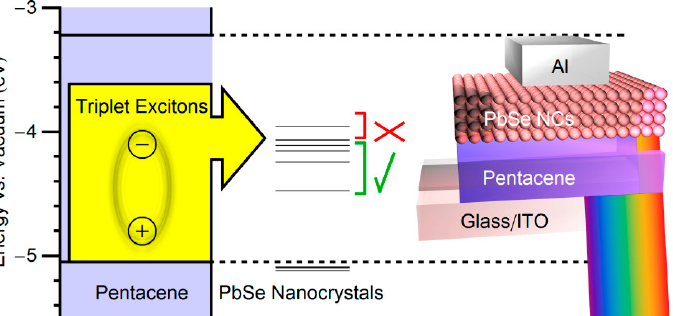
Figure 12. Illustration of the use of a size series of quantum dots with varying bandgaps to establish a lower limit on the energy of the ionizing exciton, and a schematic diagram of a pentacene/nanocrystal hybrid solar cell. Reprinted with permission from Ref. [73]. Copyright 2013, American Chemical Society.